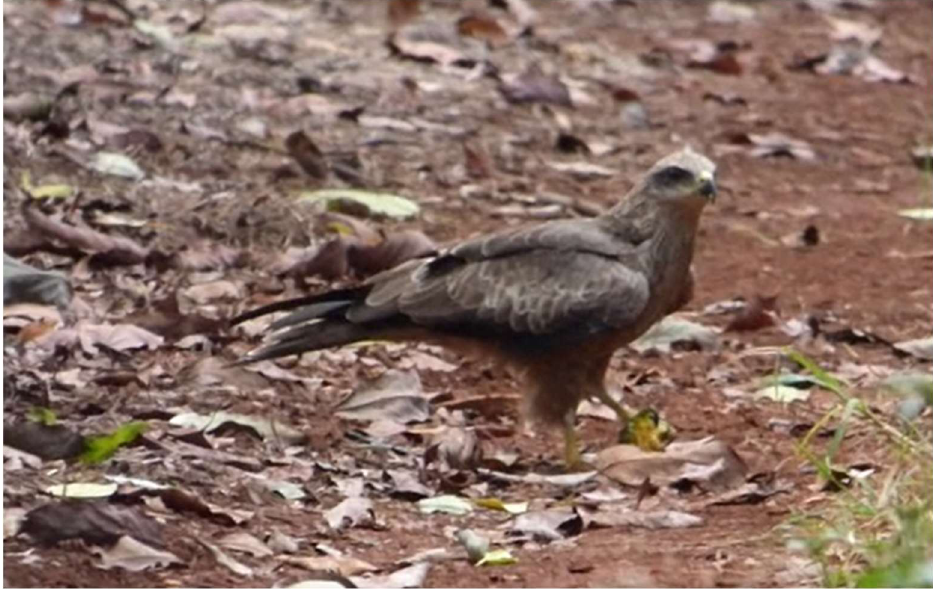
Figure 4. Black Kite with partially consumed avocado fruit held by left foot before flying off with the fruit, Mareeba, Queensland, Australia (see also Supplementary video 2). Photo: Jack